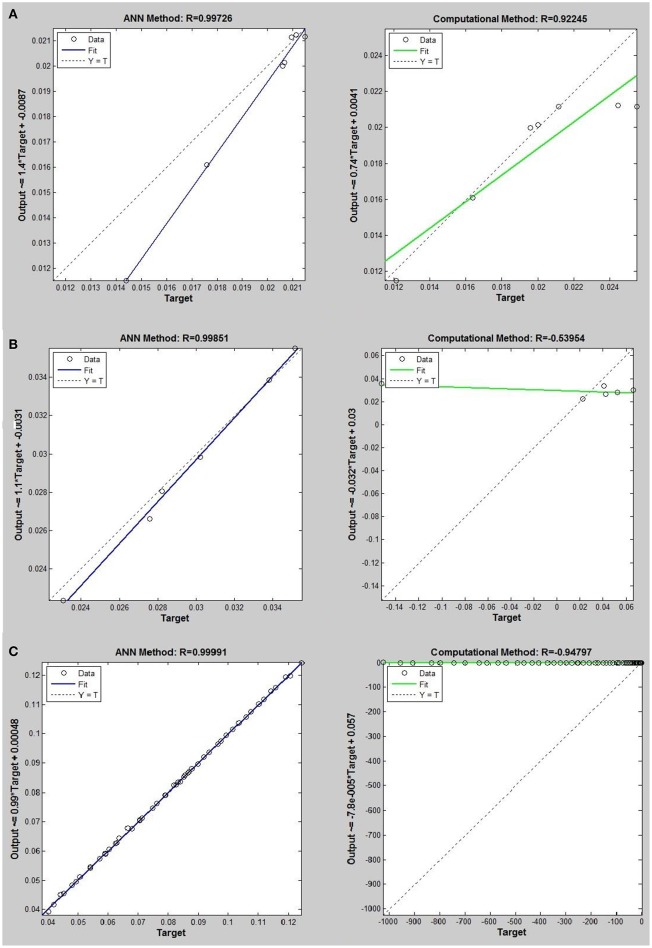
Thermal conductivity regression. Comparison between computational and ANN Methods for R12. (A) Comparition in low density (ρ < 2). (B) Comparison in moderate density (2 < ρ < 6). (C) Comparison in high density (ρ > 6).